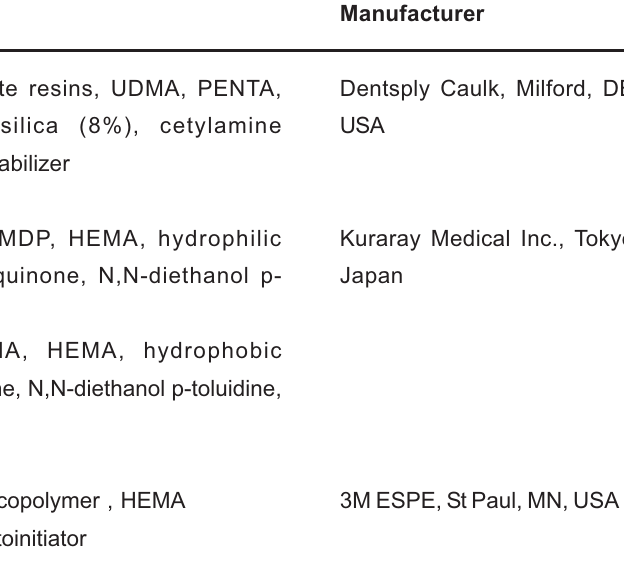
TABLE 1- Bonding Systems used in this study